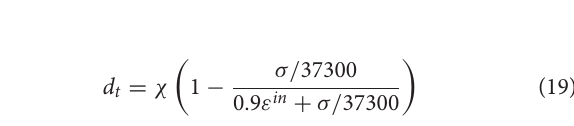
FIGURE 4 | The curves of compressive and tensile damage factors: (A) the compressive factor (B) the tensile